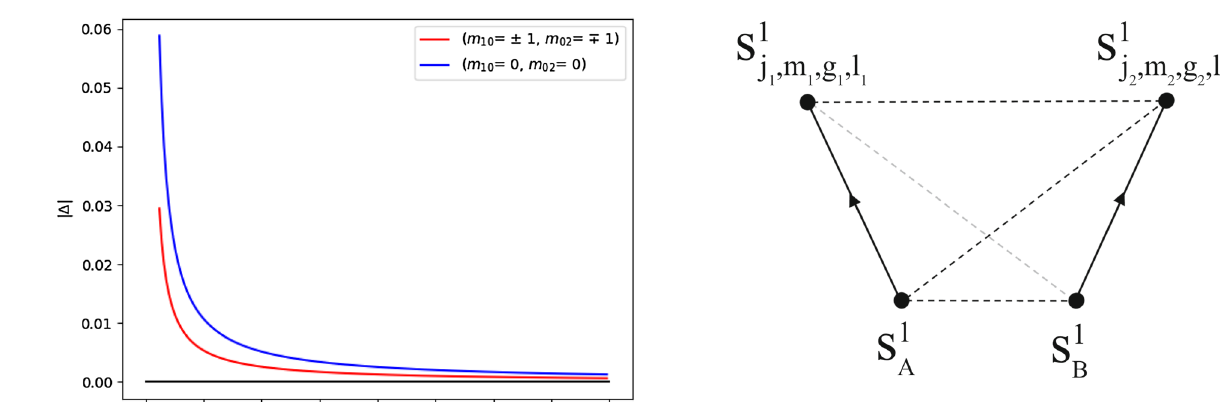
Fig. 6 A correlation of four base-two sequences, which is a base-16 sequence and an element of S 4 ( n ) , can typically be visualized as a tetrahedron. These can be interpreted as correlations between two mea- surements involving separate reference sequences, one associated with Alice (A) and one with Bob